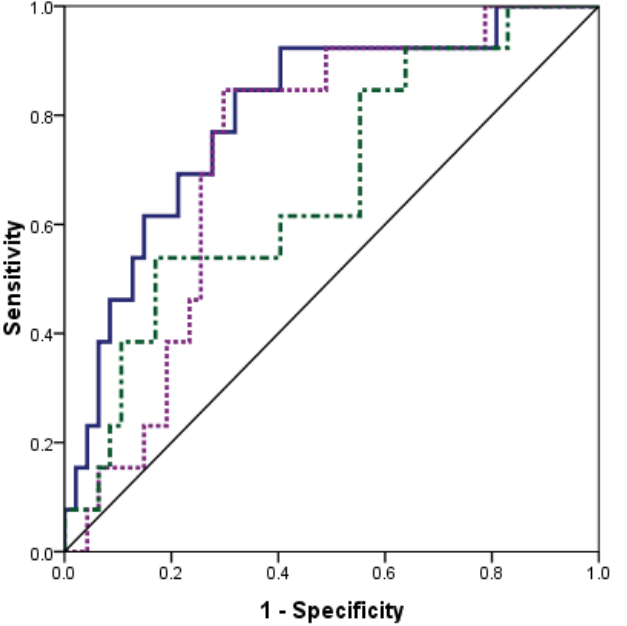
Figure 2. Parameters of the low-value predictors of mortality.